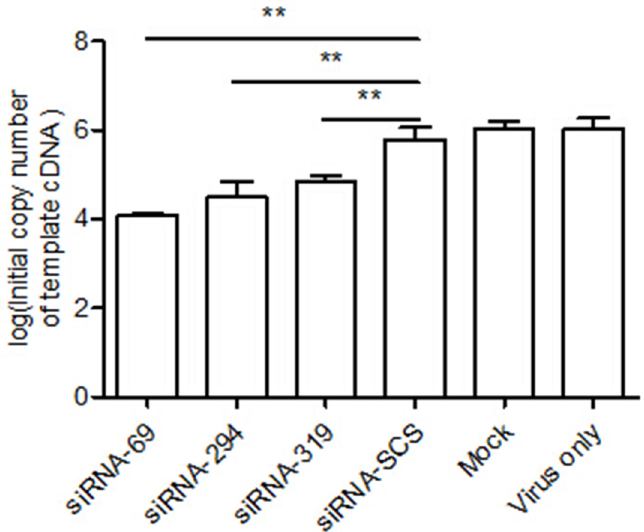
Fig 5. RNAi inhibits viral RNA. RD cells were treated with each siRNA and then infected with strain EV71- 2006-52-9 at an MOI of 0.01. At 24 h postinfection, the viral RNA was extracted and analyzed with real-time RT – PCR. The data shown represent the means ± SD of three independent experiments ( ** p < 0.01).